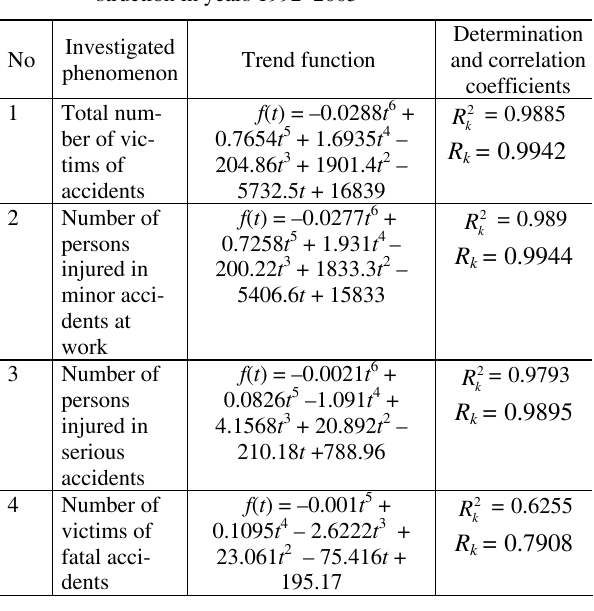
Table 1. Trend functions and determination and correlation